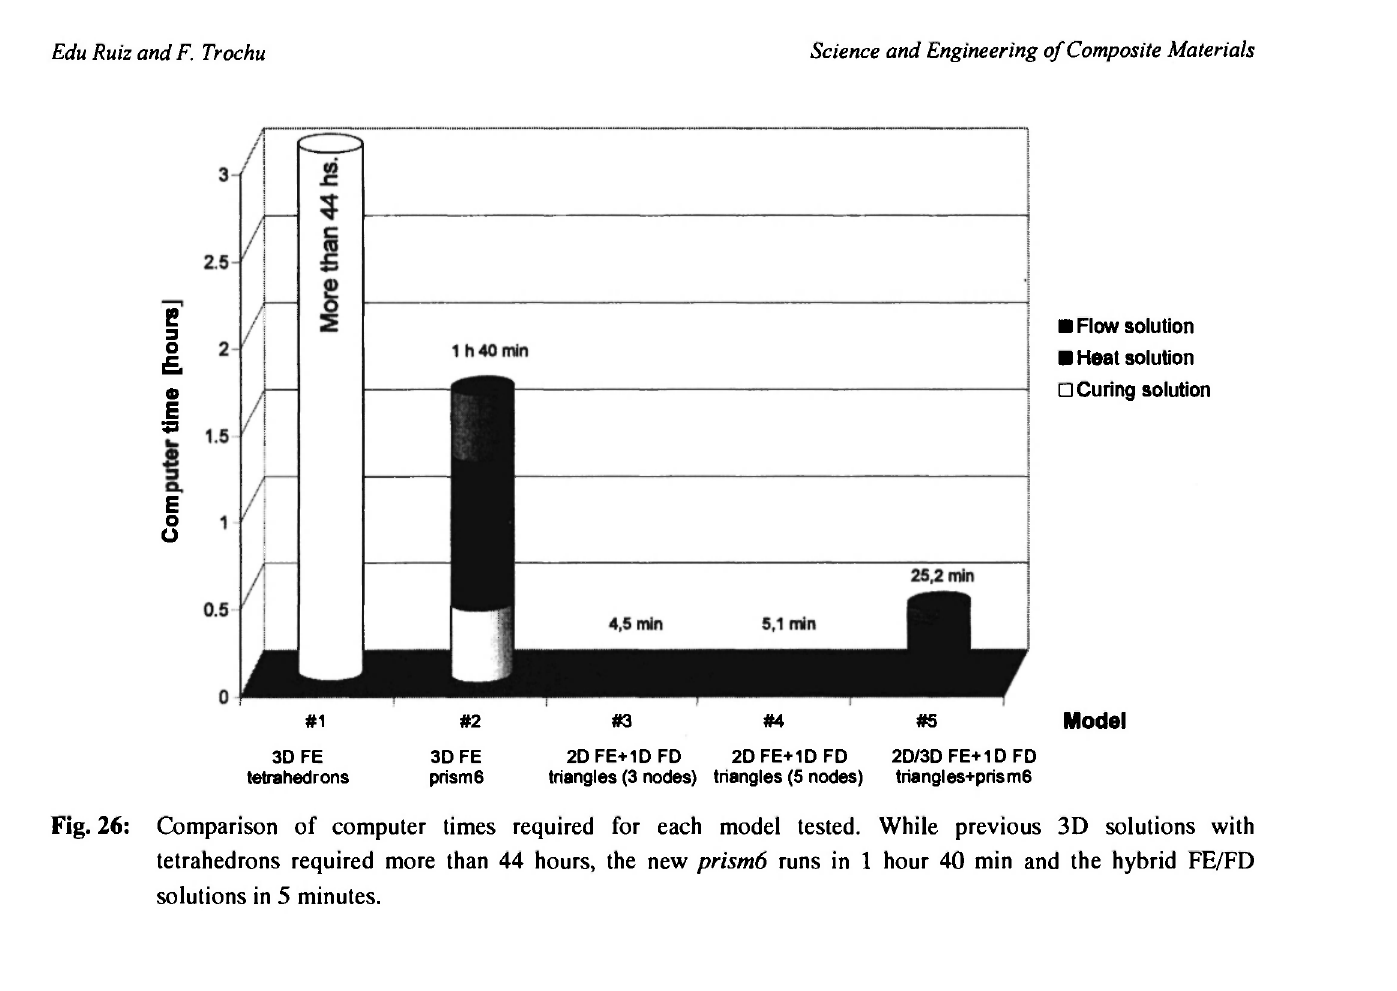
Comparison of computer times required for each model tested. While previous 3D solutions with tetrahedrons required more than 44 hours, the new prism6 runs in 1 hour 40 min and the hybrid FE/FD solutions in 5